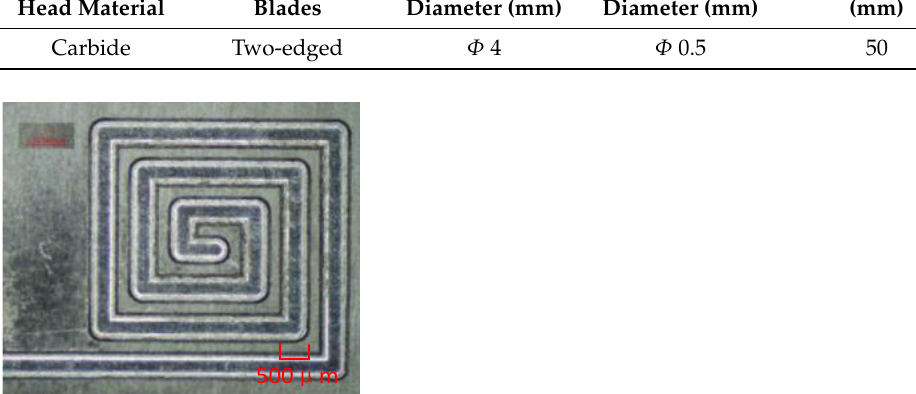
Figure 25. Micro-structure after micro-grinding. 5. Conclusions In this paper, a micro-machine tool integrated with bed structure for micro-cutting is fabricated and tested, and the dynamic and static mechanical properties of the structure under the various working conditions are studied. The overall structure has been opti- mized based on parameter analysis. The conclusions are as follows: